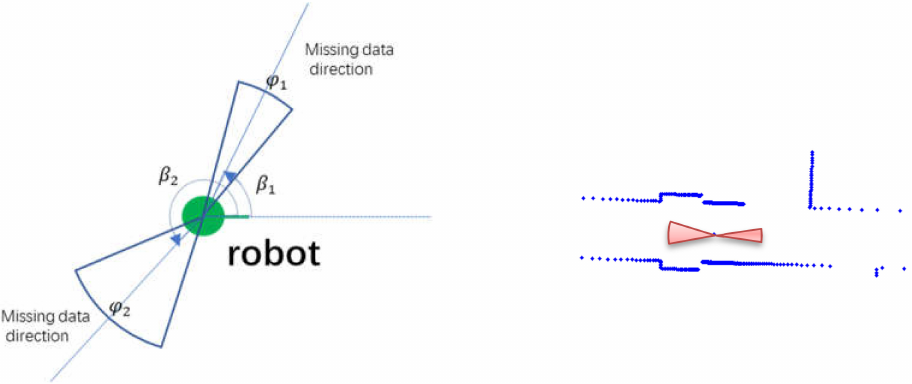
Figure 3. The expression of a missing data feature (left) and a feature in a scan scene